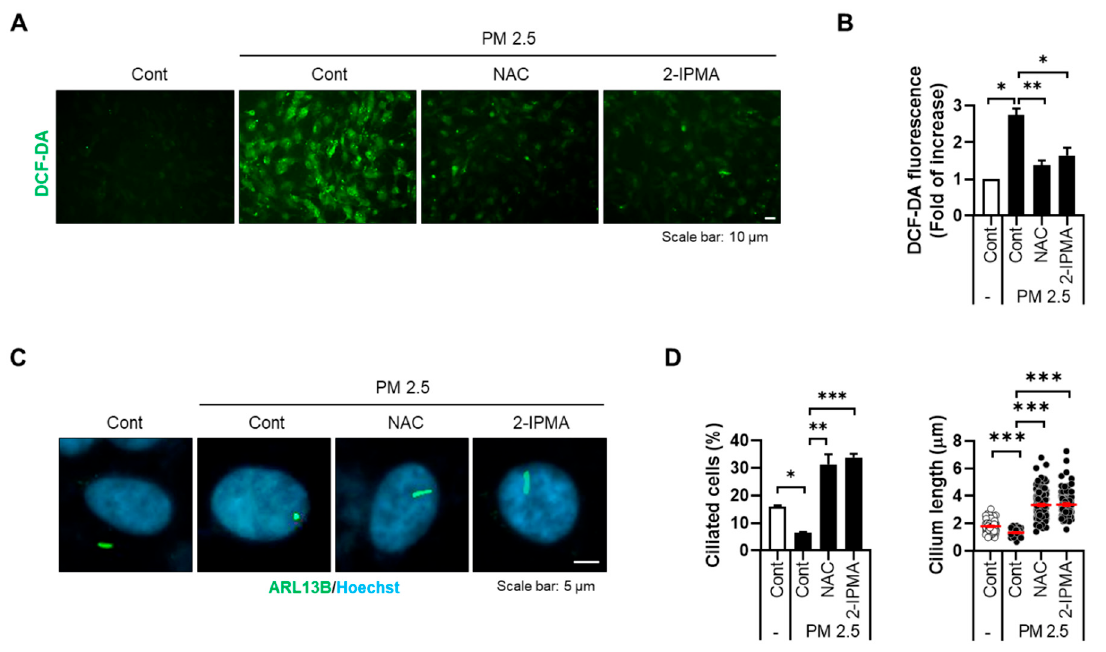
Figure 3. 2-IPMA inhibits excessive ROS generation by PM2.5 in RPE cells. ( A , B ) RPE cells were treated with PM2.5 (50 μ g/mL) in the presence of either 2-IPMA (100 μ M) or NAC (10 μ M) for 24 h. Then, the levels of cellular ROS were imaged ( A ) and measured with a DCFH-DA fluorescence ROS detection assay ( B ). Scale bar: 10 μ m. ( C , D ) RPE cells were treated with PM2.5 (50 μ g/mL) in the presence of either 2-IPMA (100 μ M) or NAC (10 μ M) for 24 h. ( C ) The cells were stained with ARL13B antibody (green) and Hoechst dye (blue). ( D ) The ciliated cells and cilium length of the cells were measured. Scale bar: 5 μ m. Data are presented as the mean ± SEM ( n = 3, * p < 0.05, ** p < 0.01, *** p < 0.001).